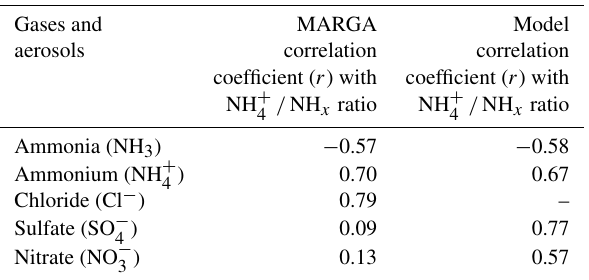
Table 1. Performance statistics of correlation coefficient ( r )